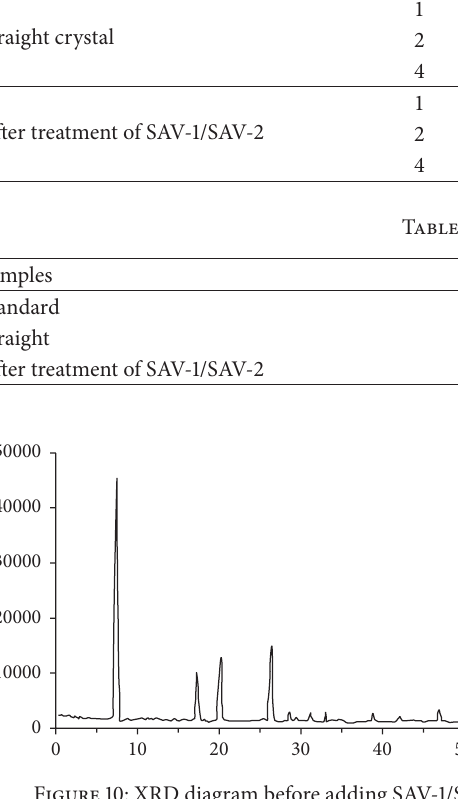
Table 2: Comparisons of diffraction data of CaSO